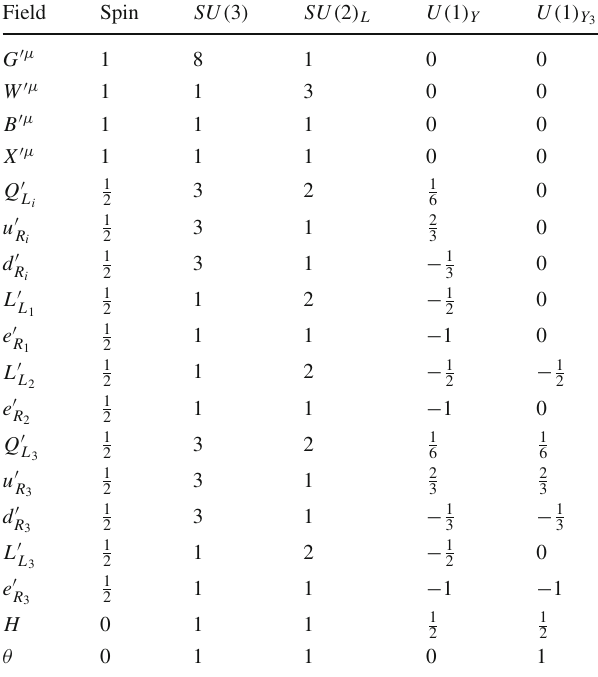
at tree-level, where g (cid:2) and g are the gauge couplings of U ( 1 ) Y and SU ( 2 ) L , respectively. The mixing between the weak eigenbasis (primed) fields and the mass eigenbasis (unprimed) fermionic fields is given by